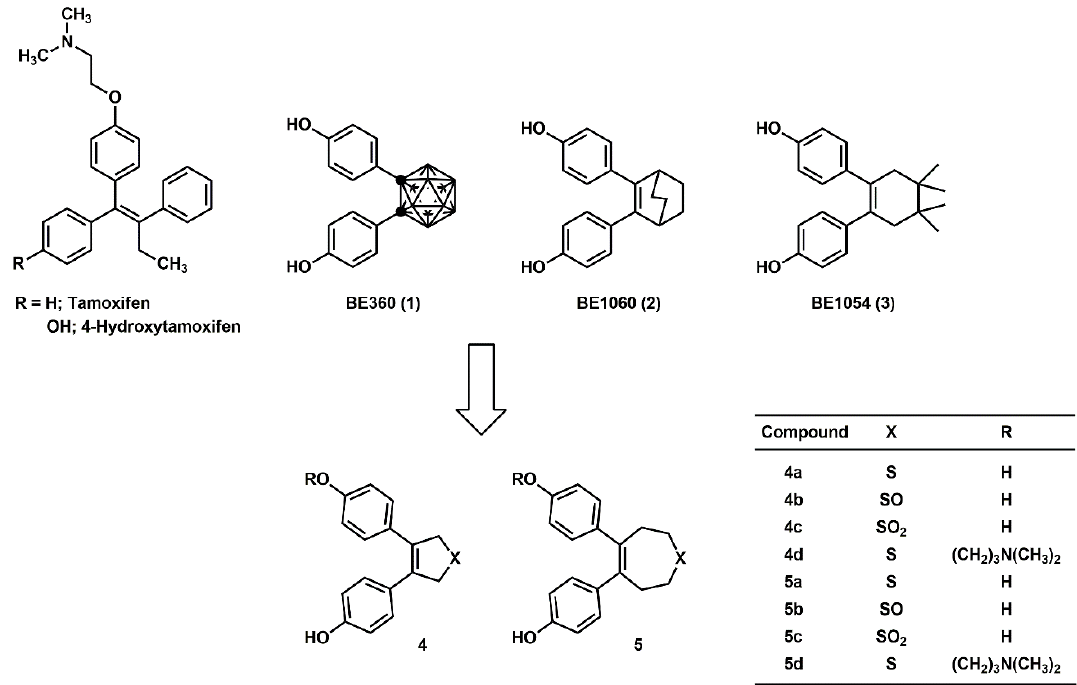
Figure 1. Structures of estrogen receptor (ER) modulators and newly designed sulfur-containing ER antagonist candidates (compounds 4a ‒ 4d and 5a ‒ 5d